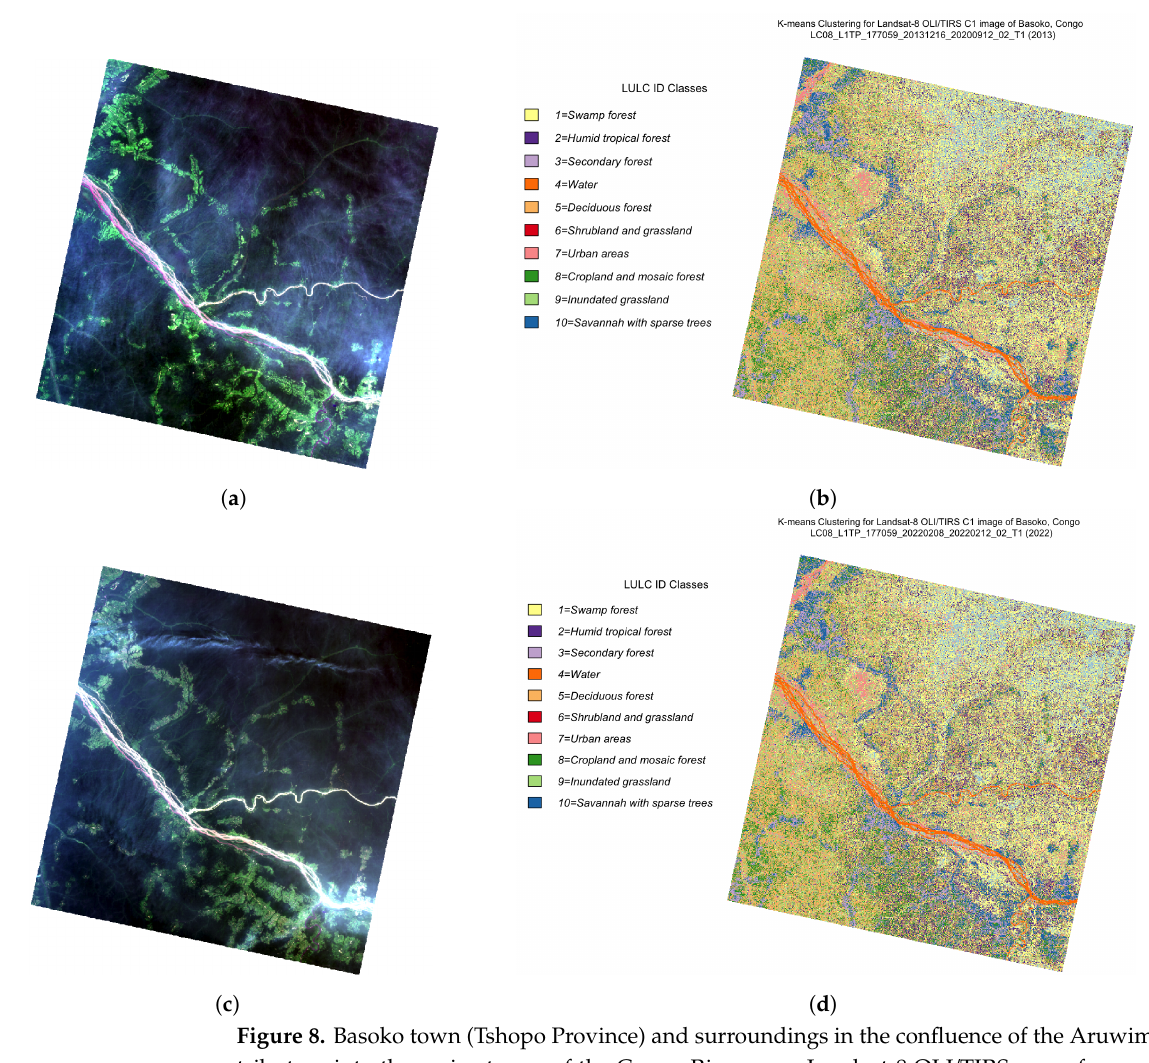
Figure 8. Basoko town (Tshopo Province) and surroundings in the confluence of the Aruwimi River tributary into the main stream of the Congo River: raw Landsat-8 OLI / TIRS scene for years 2013 and 2022 and the classified outputs by k-means clustering. Mapping: RStudio. Source: authors.